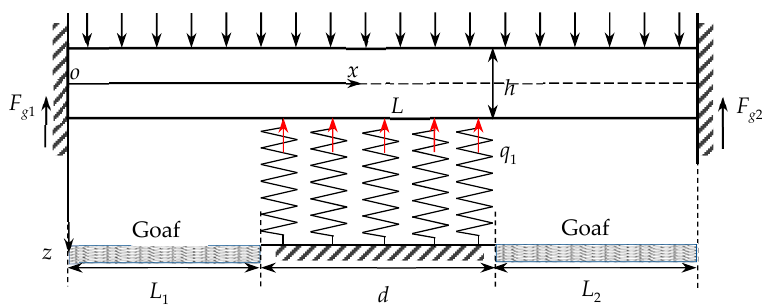
Figure 6. Mechanical model of the flexural deformation of the main key stratum (MKS).